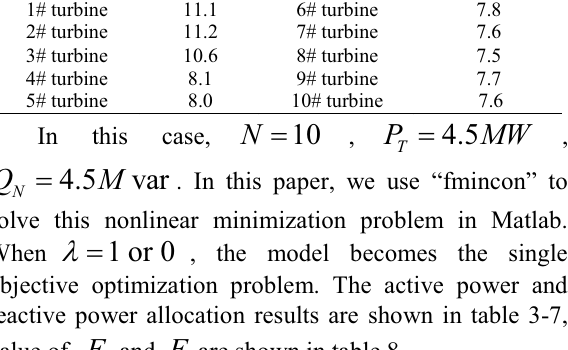
Table 2. Wind speed of every wind turbine (m/s)